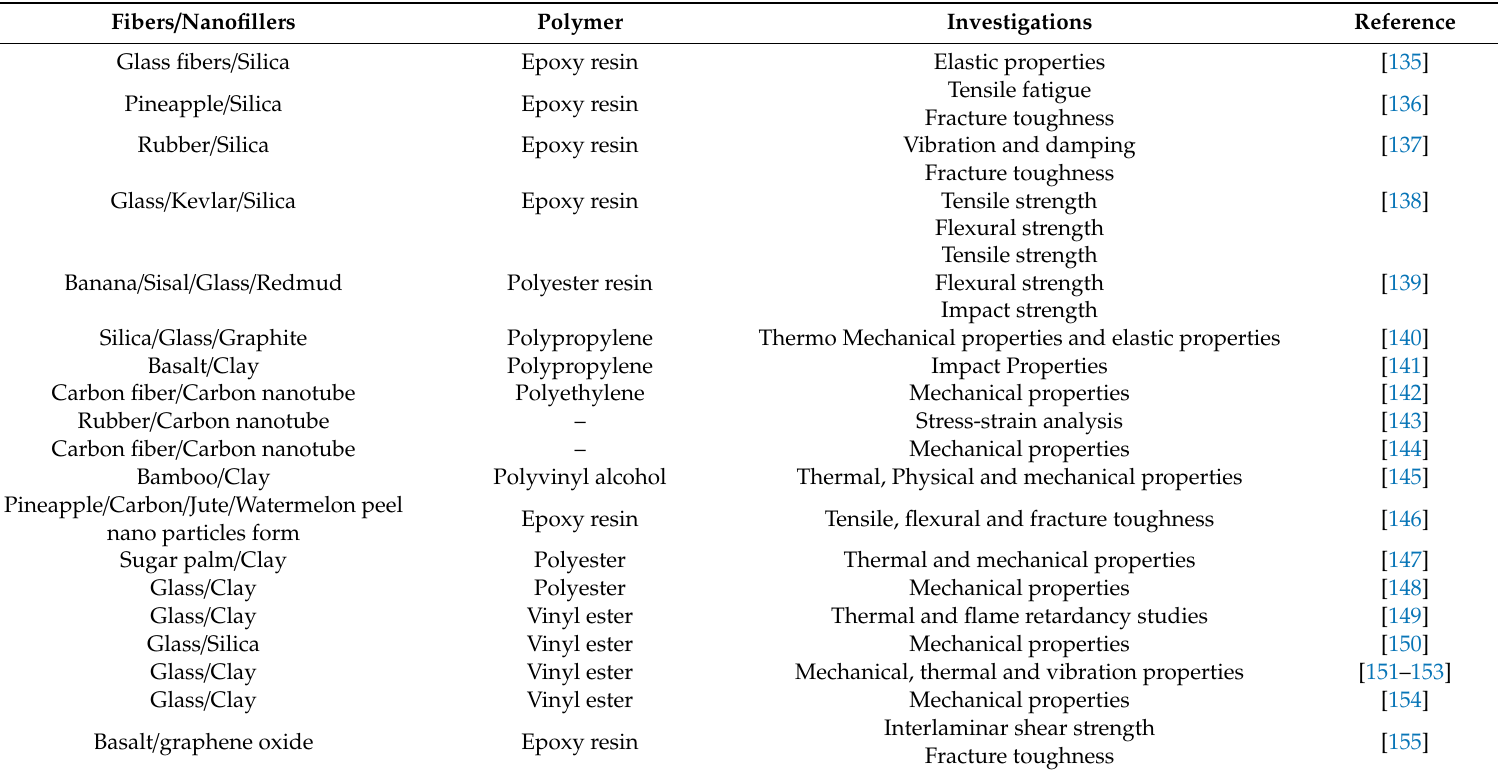
Table 14. Various research publications on nanofillers in fiber composite